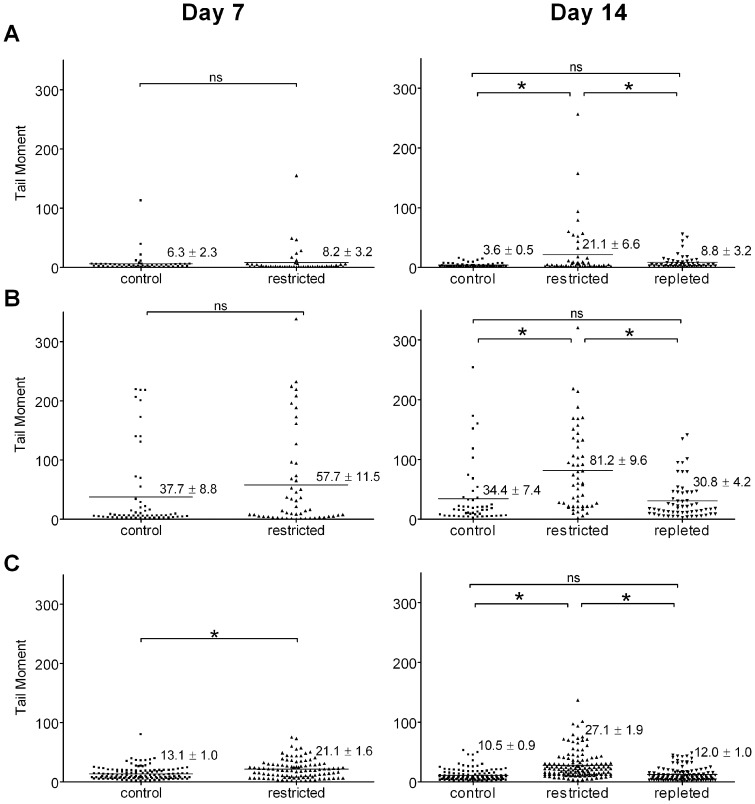
Effect of photodamage on DNA integrity in niacin-restricted HaCaT keratinocytes.DNA damage in HaCaT keratinocytes grown in the presence (control) or absence (restricted) of added niacin for 7 or 14 days was analyzed by alkaline comet assays. Dots represent the tail moment of single cells; mean tail moment is indicated by the lines shown for: (A) untreated, (B) SSL treated, and (C) singlet oxygen stress treated cells. ns, non significant difference; *, denotes significant differences, by unpaired Student’s t test, p<0.001.